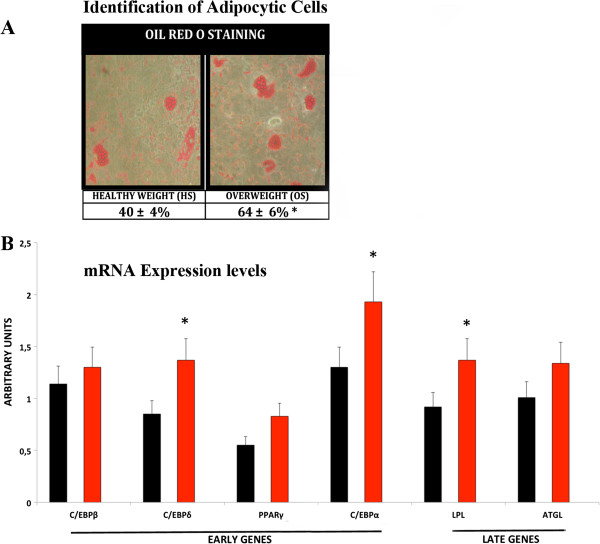
Analysis of adipocyte differentiation. A) The table shows the percentage of Oil Red O positive cells treated with OS or HS and then induced to differentiate into adipocytes. The percentage of Oil Red O positive cells was calculated by counting at least 500 cells in different microscope fields. Data are expressed as mean values with standard deviations (*P <0.05). The picture shows a representative field of oil-red positive cells. B) RT-PCR expression analysis of early and late adipocyte differentiation markers in MSCs treated with OS or HS and then induced to differentiate into adipocytes. mRNA levels were normalized with respect to GAPDH, which was chosen as an internal control. Each experiment was repeated at least three times. The histogram shows the changes in mRNA expression levels 14 days after incubation in differentiation conditions of MSCs grown in OS (red bars) or HS (black bars). They are expressed as arbitrary units (*P <0.05). HS, healthy weight sera; MSCs, mesenchymal stem cells; OS, overweight sera.